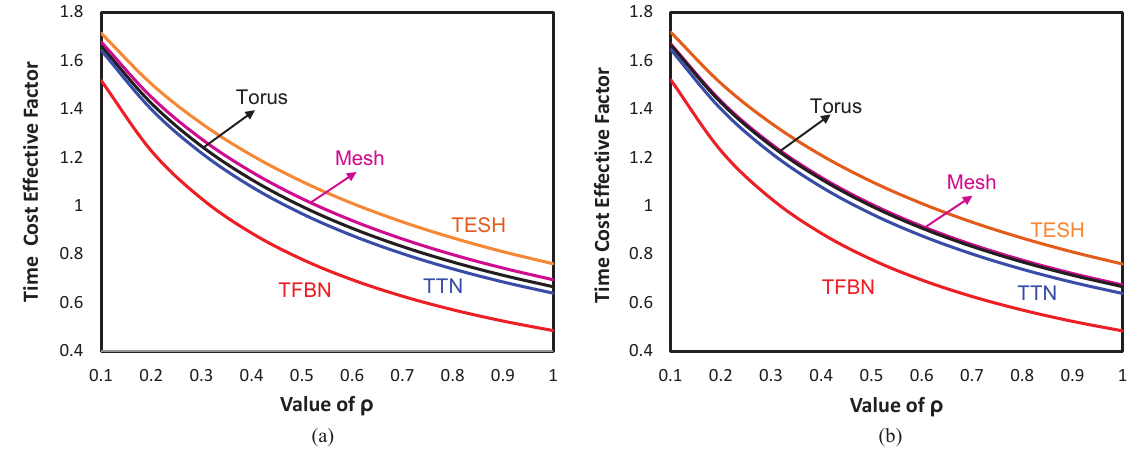
Figure 5. Comparison of static time cost-effective factors of various interconnection networks considering different values of ρ ( a ) network size 256 nodes; ( b ) network size 4096